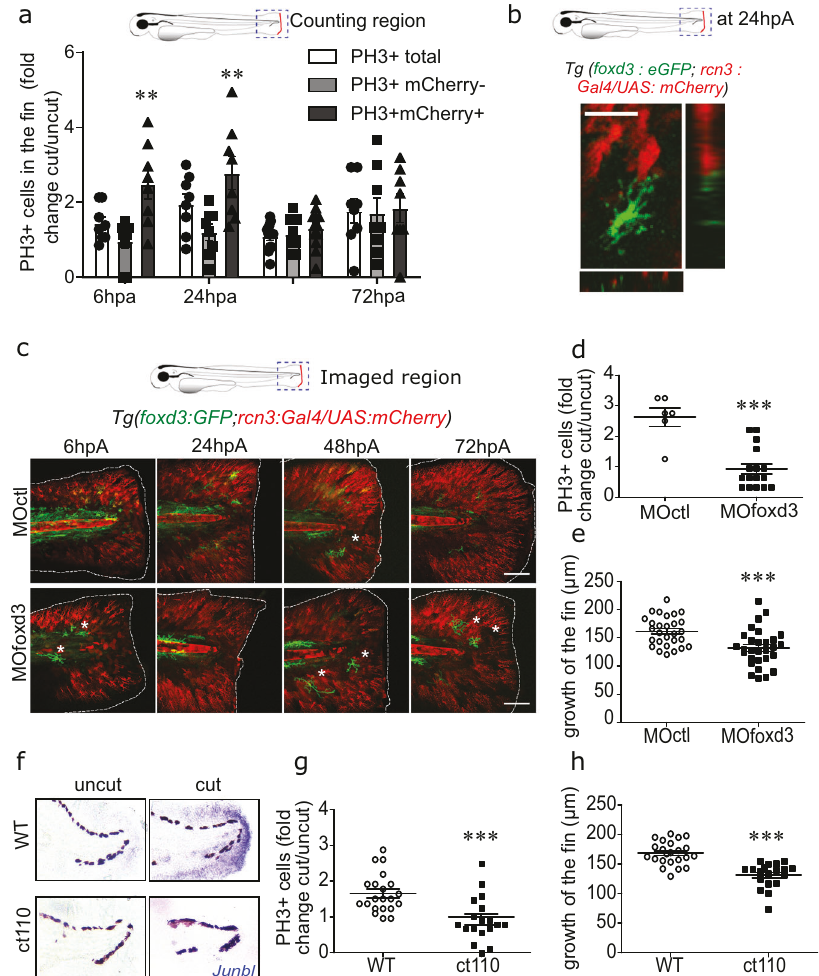
Fig. 3 Foxd3 + NCdC are required for blastemal cell proliferation and zebra fi sh caudal fi n fold regeneration. a Quanti fi cation of cell proliferation in the blastema of Tg(rcn3:Gal4/UAS:mCherry) larvae from 6hpA to 72 hpA. Mitotic cells were detected using an anti-PH3 antibody. Data are shown as fold change relative to the age-matched uninjured controls, and are the mean ± SEM, n = 8 (for the 6, 24, 72 hpA time points), n = 12 (for the 48 hpA time point), ** p < 0.01. b Image of a time-lapse z-stack sequence of a Tg(foxd3:eGFP-F/rcn3:Gal4/UAS:mCherry) larvae at 24 hpA with x and y projections using the Fiji software (Scale bar = 8 µ m). c Confocal images of caudal fi n fold of Tg(foxd3:eGFP-F/rcn3:Gal4/UAS:mCherry) larvae injected with MO ctl or MO foxd3 at 3 dpf, and then from 6 hpA to 72 hpA (asterisks show pigments, scale bars = 80 µ m, representative of n = 5 larvae from 3 independent experiments). d Blastemal cell proliferation in foxd3 and control morphants was assessed using an anti-PH3 antibody at 24 hpA. Data are shown as fold change relative to the age-matched uninjured controls, and error bars are the SEM, n = 6 (for the control group) and n = 16 (for the foxd3 morphants) biologically independent larvae, one-tailed Mann – Whitney test was performed, p = 0.0007, *** p < 0.001. e Quanti fi cation of caudal fi n fold length in foxd3 and control morphants at 72hpA. Error bars are the SEM, n = 21 biologically independent larvae, one-tailed Mann-Whitney test was performed, p = 0.0002, *** p < 0.001. f The mRNA expression of the blastemal marker junb-l (blue) was detected by in situ hybridization at 24 hpA in control and amputated fi n folds from 4 dpf wild type (WT) and Tg(foxd3:mCherry) ct110 (ct110) mutant larvae (representative of n = 15 biologically independent larvae per groups). g Blastemal cell proliferation in heterozygotes (WT) and homozygotes (ct110) Tg(foxd3:mCherry) ct110 larvae at 24 hpA was detected using an anti-PH3 antibody (graph represents the mean number of positive cells ± SEM, n = 21 (for the WT groups) and n = 18 (for mutants) larvae from 3 independent experiments, one-tailed Mann-Whitney test was performed, p = 0.0002, *** p < 0.001). ( h ) Quanti fi cation of fi n fold growth at 72hpA in WT and Tg(foxd3:mCherry) ct110 mutant 6 dpf larvae (graph represents the mean ± SEM, n = 22 (for the WT group), n = 19 (for the mutant group) biologically independent larvae, one-tailed Mann Whitney test was performed, p = 0.0001, *** p <